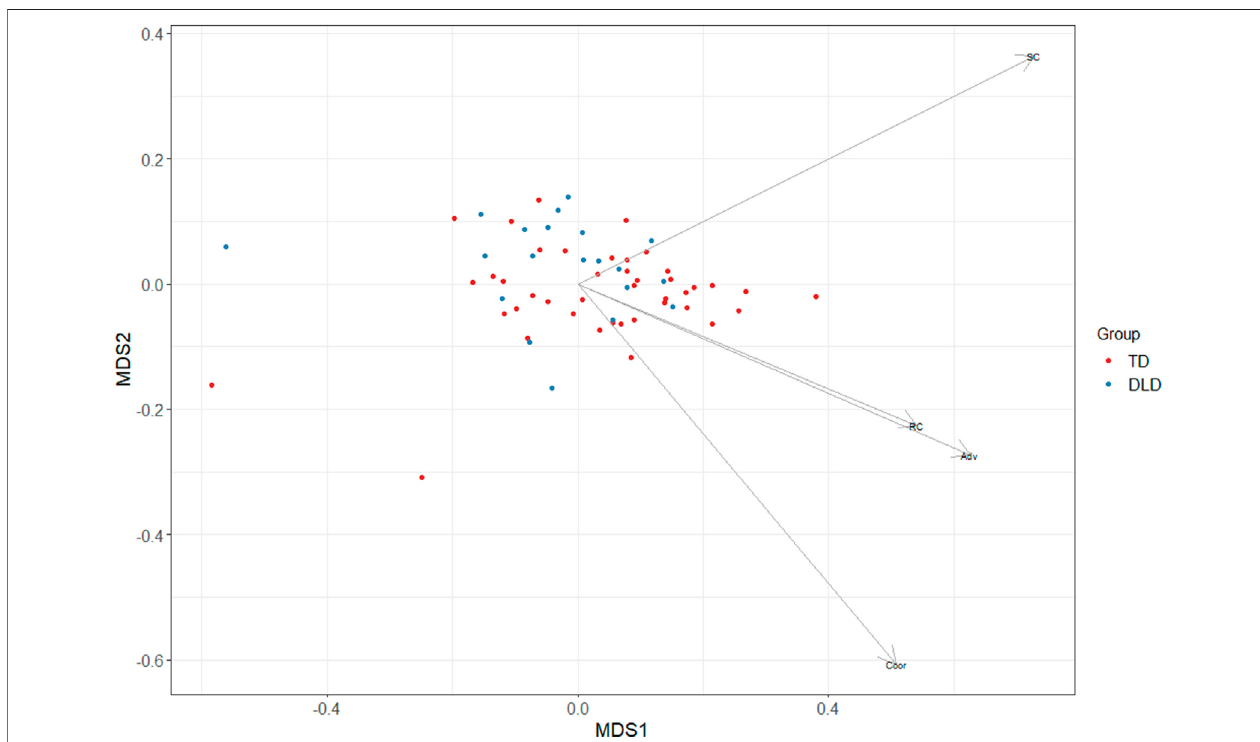
FIGURE3 | PERMANOVA results forcomplexclause type. Notes: MDS1 (cid:1) Multidimensional scaling ordinate 1; MDS2 (cid:1) Multidimensional scaling ordinate 2;TD (cid:1) typical development;DLD (cid:1) developmentallanguagedisorder;Coor (cid:1) coordinatedclauses;RC (cid:1) relativesclause;Adv (cid:1) Adverbialclauses;SC (cid:1) sententialcomplement clause.